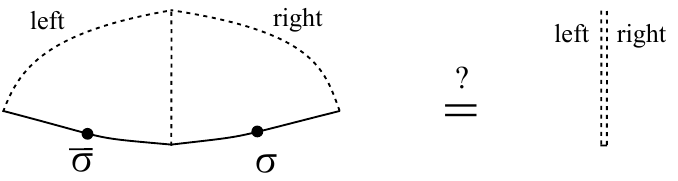
Figure 2 . Schematic representation of the identity (cid:6)(cid:6) = 1. This relation appears to be